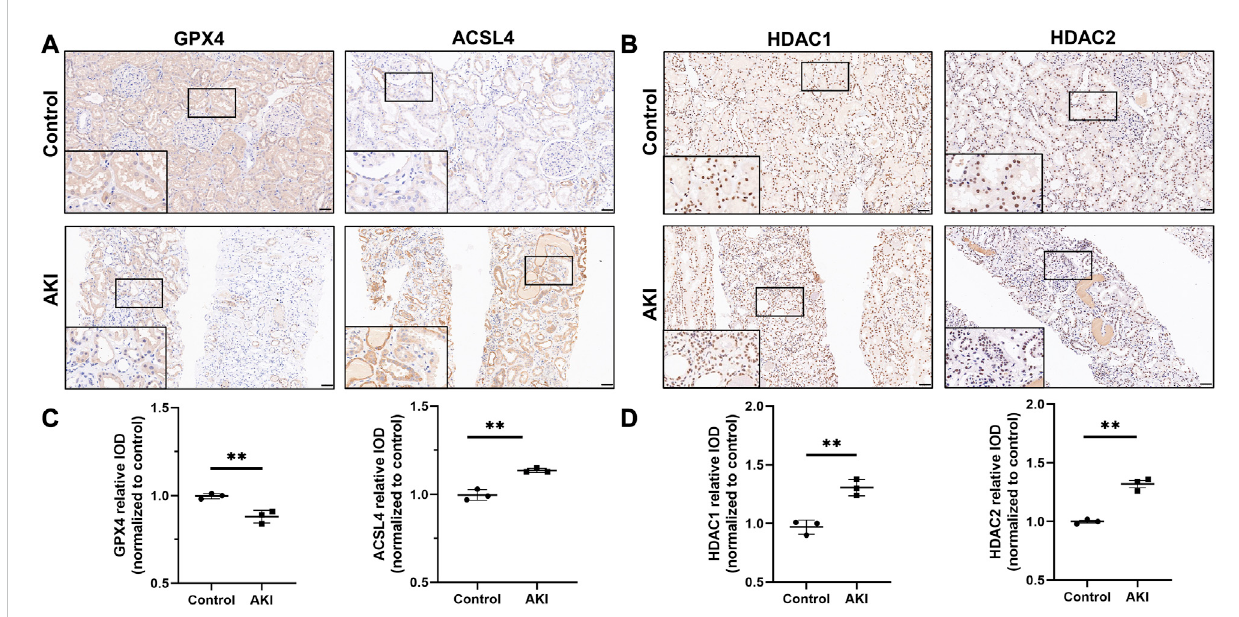
FIGURE 1 The expression of GPX4, ACSL4, HDAC1 and HDAC2 in acute kidney injury from human biopsies. Representative images of immunohistochemistry of GPX4 and ACSL4 (A) , HDAC1 and HDAC2 (B) in the healthy control and AKI human kidney biopsy specimens. Scale bar = 50 μ m. Quanti fi cation of examining positive staining area of GPX4 and ACSL4 (C) , HDAC1 and HDAC2 (D) in tubulointerstitium normalized to healthy control (Non-tumor kidney tissue from the patients who had renal cell carcinoma and underwent nephrectomy was used as control). n = 3. ✱✱ value p < 0.01. Statistically analyzed via a one-way ANOVA with Dunnett ’ s